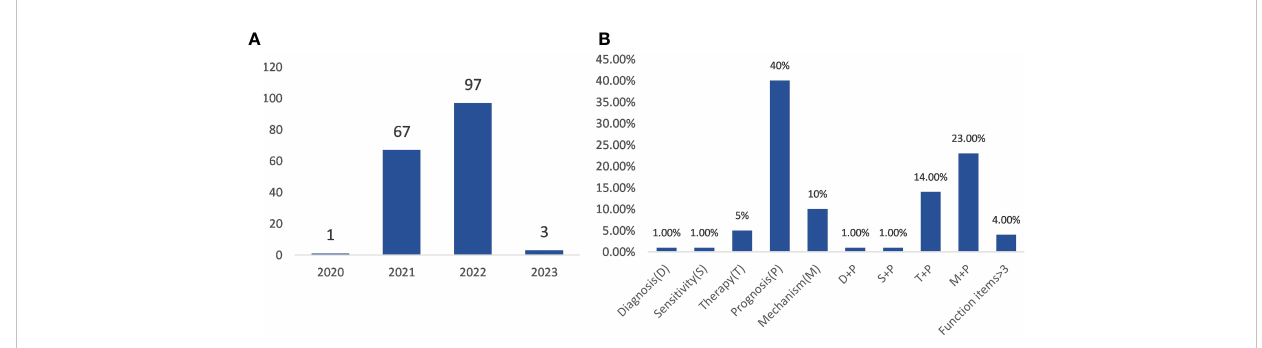
FIGURE 8 Analysis of gene signature-related articles. (A) the time distribution of gene signature-related article publications; (B) the ratio of research direction to gene